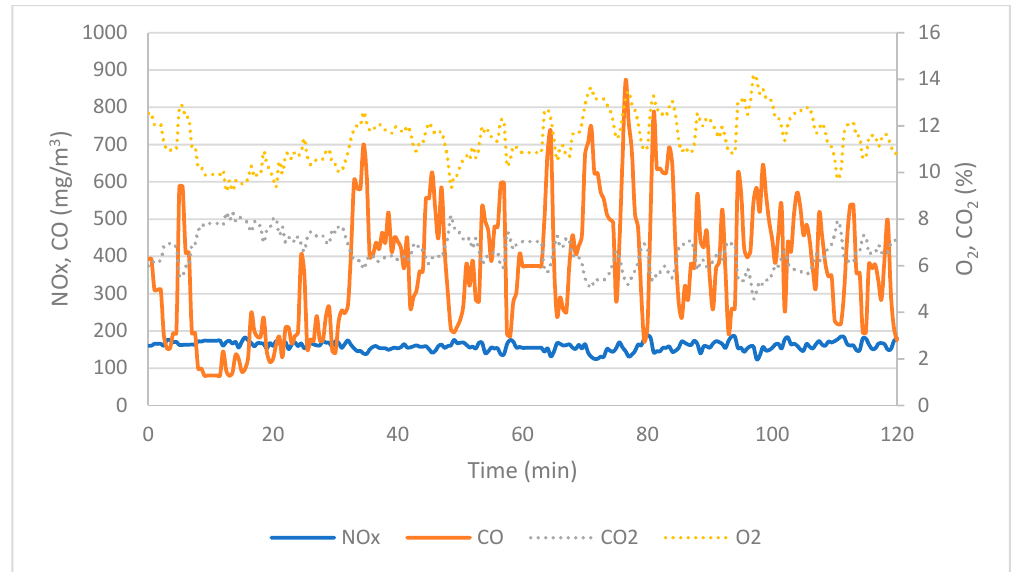
Figure 8. CO and NOx emissions, oxygen and carbon dioxide volume in the exhaust gas during combustion of wood pellets, minimum load.